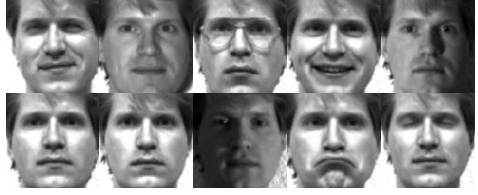
Figure 3. Samples of one subject from YALE database.